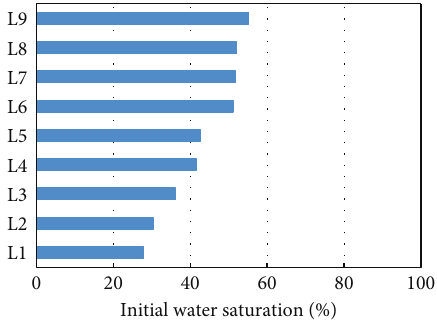
Figure 2: Initial water saturation of reservoir